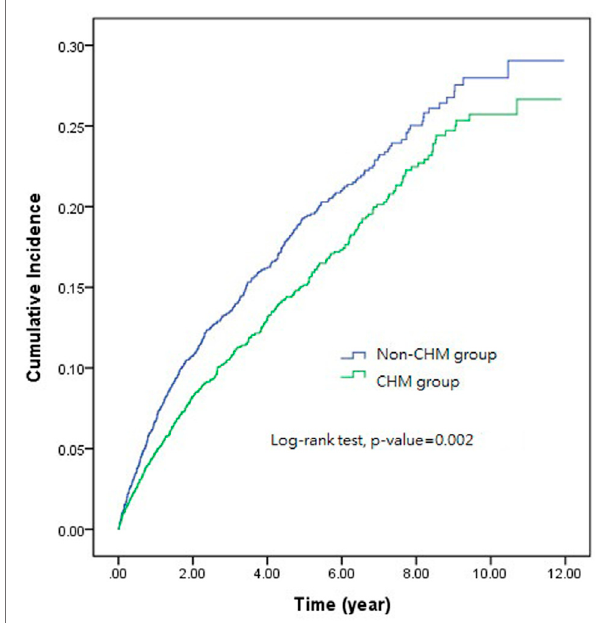
FIGURE 2 | The cumulative incidence of cardiovascular disease between systemic lupus erythematosus patients treated with and without Chinese herbal medicines.CHM, Chinese herbal